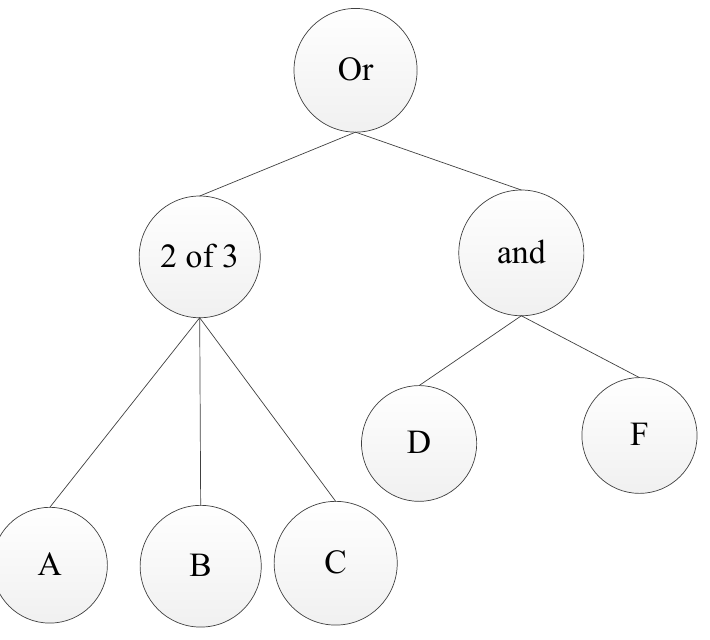
Figure 1. Accesstree